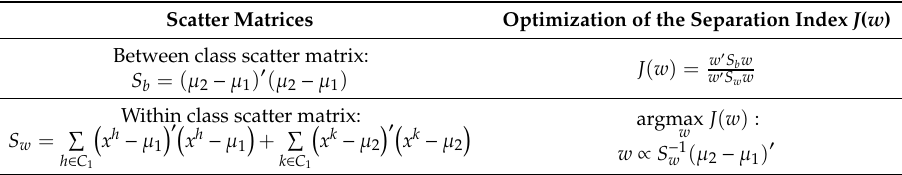
Table 10. Linear discriminant analysis (LDA).